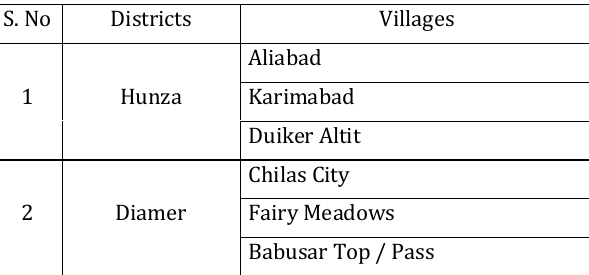
Table 3. Selected villages